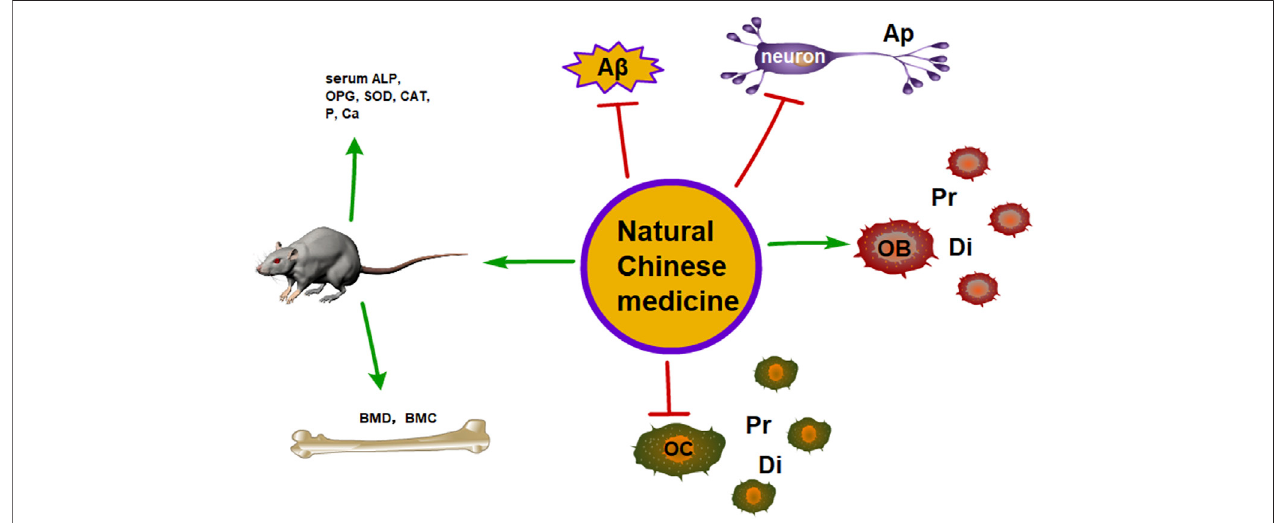
FIGURE 1 | The therapeutic potential of the natural Chinese medicine for the treatment of AD and OP (Ap, apoptosis; Pr, proliferation; Di, differentiation).